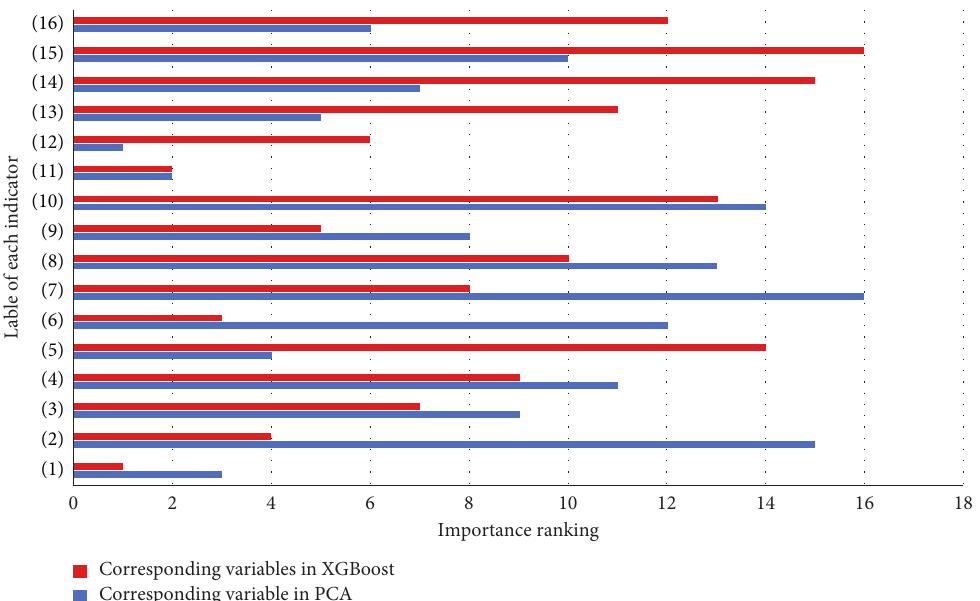
Figure 6: Comparison of subjective cognitive survey results and machine-learning algorithm output.